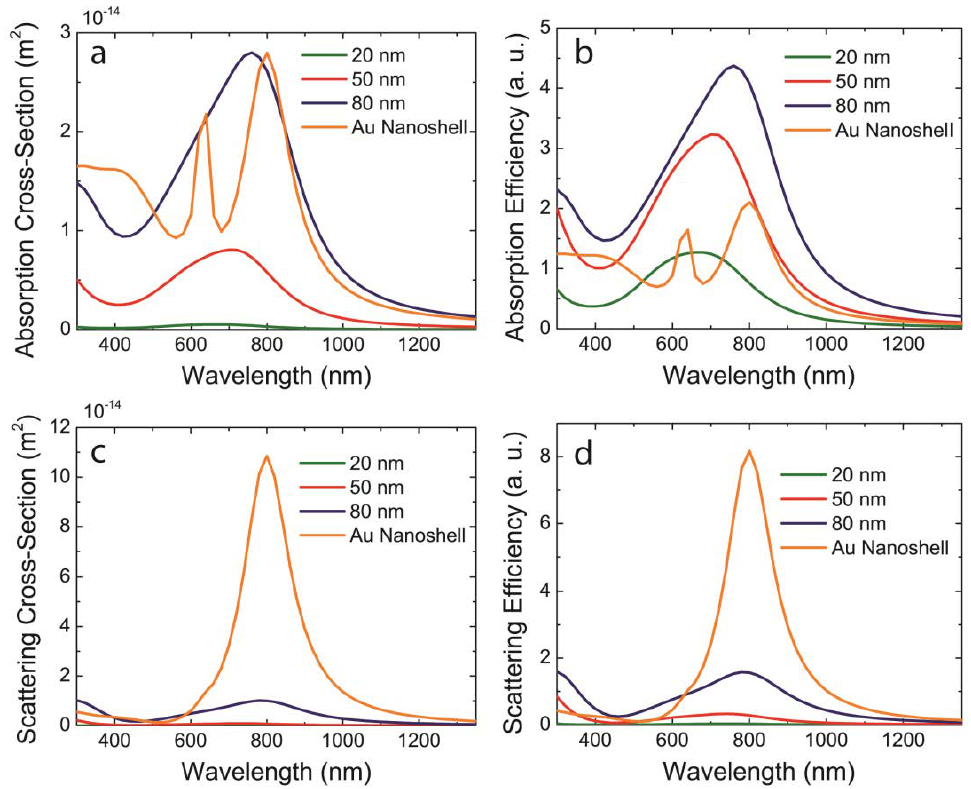
Figure 3: (a) Calculated absorption cross-section of TiN nanoparticles with sizes of 20, 50 and 80 nm compared to Au nanoshell with inner and outer diameters of 110 and 130 nm, respectively. (b) Absorption eflciencies of the same nanoparticles. Higher eflciencies in the biolog- ical transparency window obtained with smaller TiN nanoparticles would resolve problems arising from larger sizes of Au nanoshells. (c-d) Scattering cross-section and eflciencies of the same nanoparticles. Au nanoshell provides higher scattering eflciencies due to a larger particle size and more metallic behavior of the material. Eflciencies are calculated as optical cross-sections normalized by geometric cross- sections